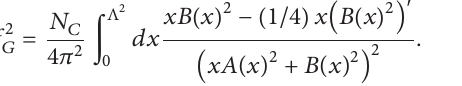
momentum above 2𝑚 𝑄 . We note that 2𝑚 𝑄 is a physical scale parameter that is external to the scale-invariant gap